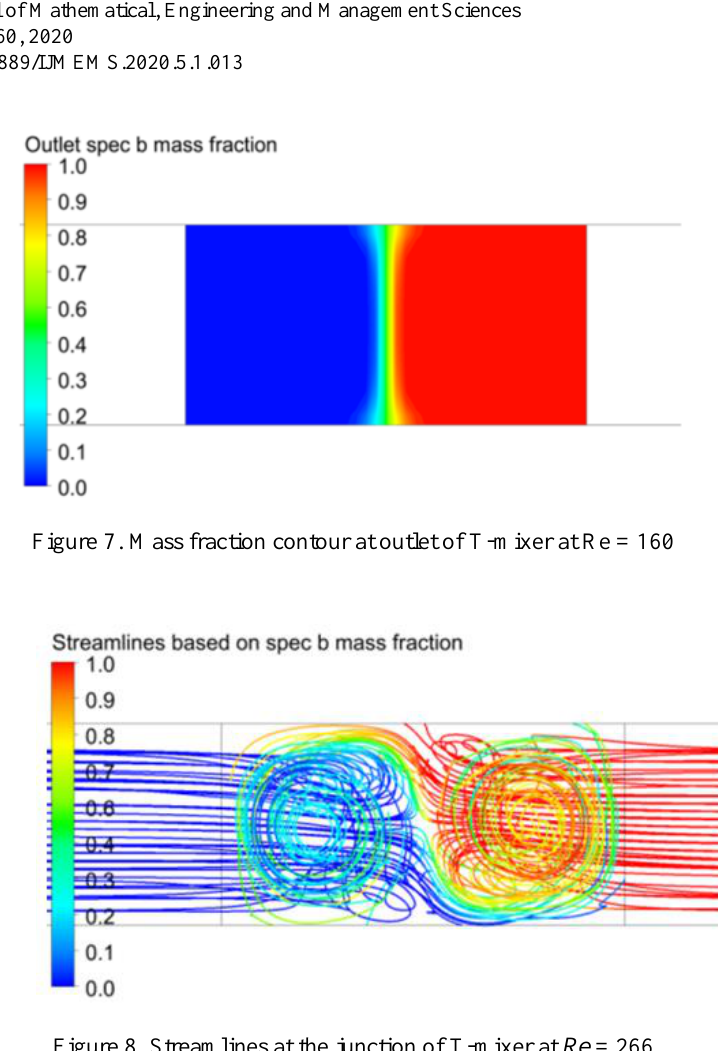
Figure 8. Streamlines at the junction of T-mixer at Re = 266